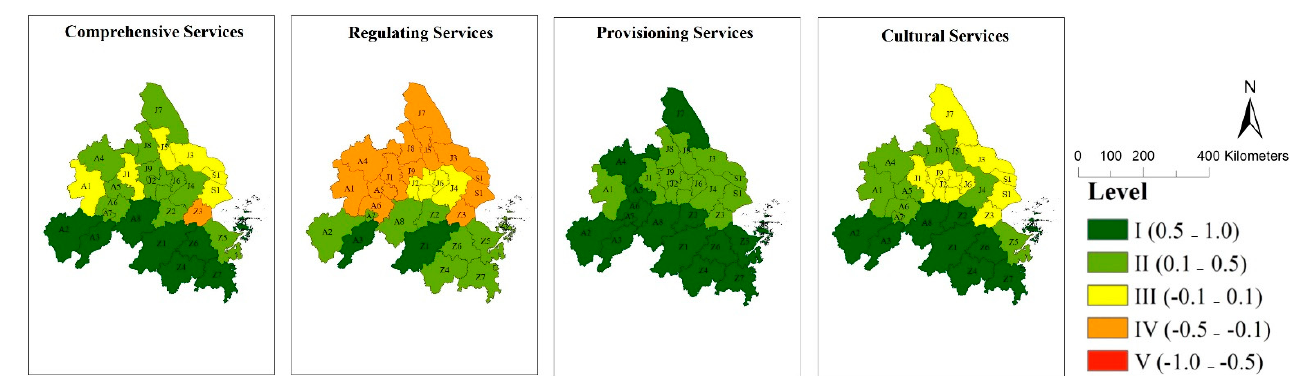
Figure 5. Spatial Pattern and Levels of Type of Comprehensive Services, Regulating Services, Provisioning Services and Cultural Services: (A1) Hefei, (A2) Anqing, (A3) Chizhou, (A4) Chuzhou, (A5) Ma’anshan, (A6) Tongling, (A7) Wuhu, (A8) Xuancheng in Anhui Province; (J1) Nanjing, (J2) Changzhou, (J3) Nantong, (J4) Suzhou, (J5) Taizhou ‐ J, (J6) Wuxi, (J7)Yancheng, (J8) Yangzhou, (J9) Zhenjiang in Jiangsu Province; (S1) Shanghai Municipality; (Z1) Hangzhou, (Z2) Huzhou, (Z3) Jiaxing, (Z4) Jinhua, (Z5) Ningbo, (Z6) Shaoxing, (Z7) Taizhou ‐ Z, and (Z8) Zhoushan.